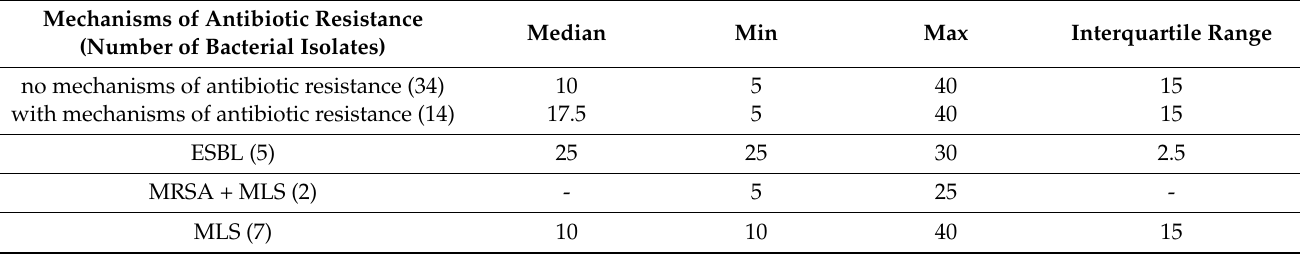
Table 2. The upper limit of minimal inhibitory concentration (MIC) of TA-AgNPs for clinical isolates with and without mechanisms of antibiotic resistance (mg L − 1 ). MIC values did not have a normal distribution; therefore, the median was used as a measure of central tendency and the interquartile range was used as a measure of statistical dispersion. Higher MIC values indicate lower sensitivity to TA-AgNPs. ESBL—extended-spectrum beta-lactamases; MRSA—methicillin-resistant